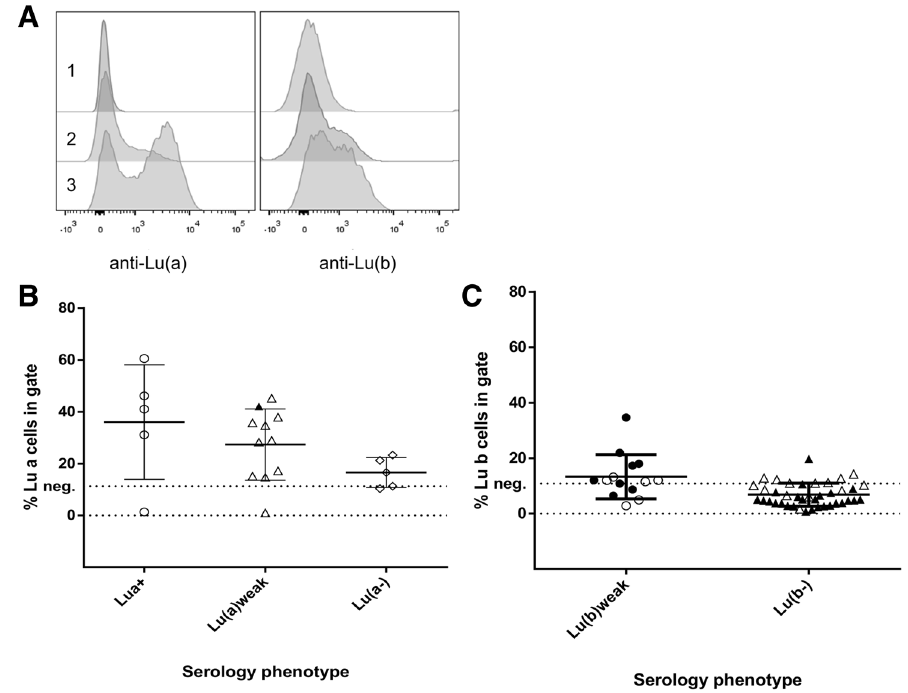
Figure 1. Typing erythrocytes for the Lu blood group by flow cytometry reveals a mixed field expression. (A) Representative Flow Cytometry LuA and LuB single stains experiments showing Lutheran expression as histograms for specific donors (1–3). Histograms show individuals negative for Lu(a, b) (1), weak expression of Lu(a, b) (2) and positive for Lu(a, b) (3). Note the negative Lutheran populations. (B) Graph shows a correlation plot between FCM (y-axis; % of positive cells) and serology typing (x-axis) for individuals carrying the Lutheran A gene. Dotted line represents the cut-off range set for Lutheran negativity Lu(a) < 11.30%. Serology was more sensitive in two cases, and FCM was more sensitive in three cases. Genotype was considered, open symbols resemble (heterozygous) LuAB carriers, closed symbols resemble (homozygous) LuAA carriers. Homozygous LuBB carriers were excluded. (C) Correlation between FCM and serology for individuals carrying the Lutheran B gene (with a cut-off for Lu(b) < 10.84%). Serology was more sensitive in 5 cases, and FCM was more sensitive in eight cases. Zygosity was considered, open symbols resemble (heterozygous) LuAB carriers, closed symbols resemble (homozygous) LuBB carriers (homozygous LuAA carriers were